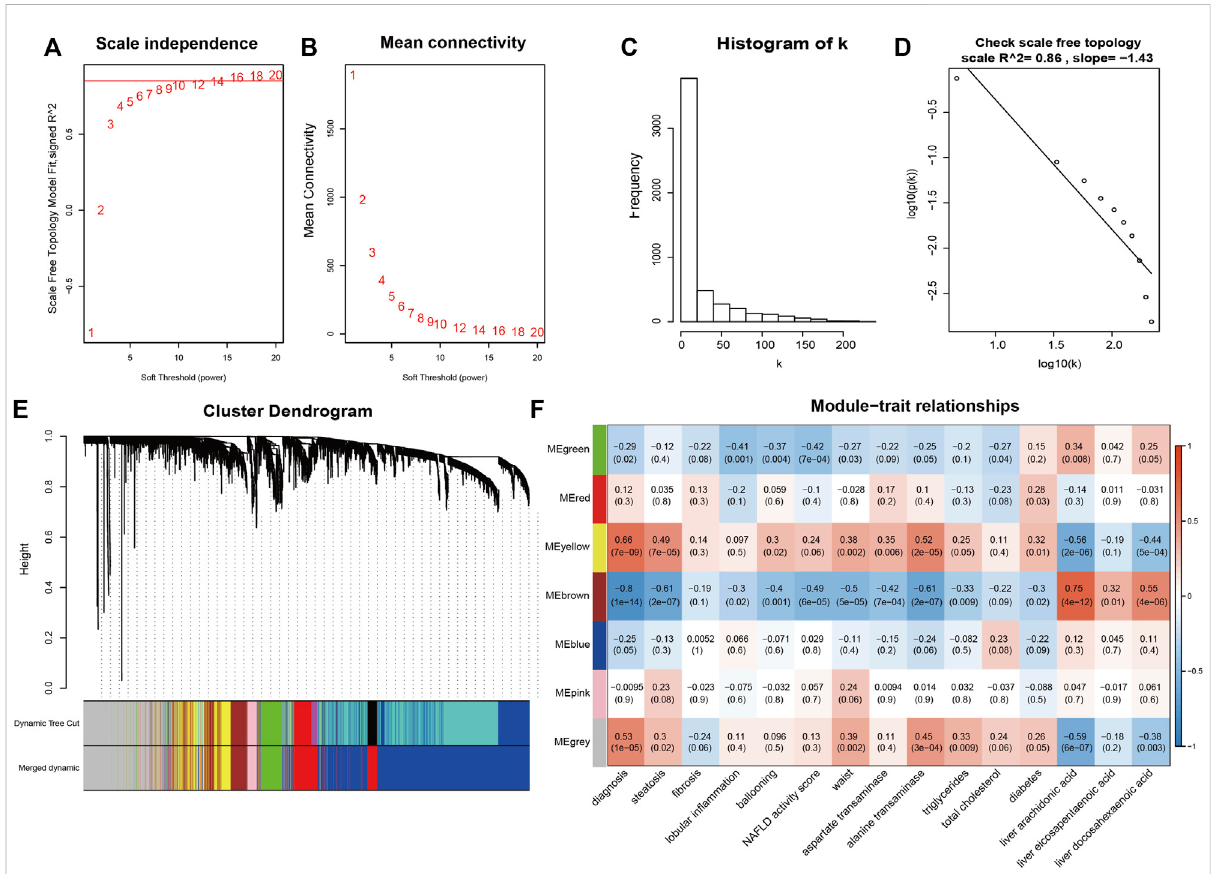
FIGURE 4 Weighted correlation network construction. (A,B) The soft-threshold β was chosen to be 16. (C,D) Log-log plot of whole-network connectivity distribution. The x-axis shows the logarithm of the whole network connectivity, and the y-axis is the logarithm of the corresponding frequency distribution. The network met the requirements of scale-free topology. (E) A total of 6 module was detected. (F) The correlation heatmap for gene modules and